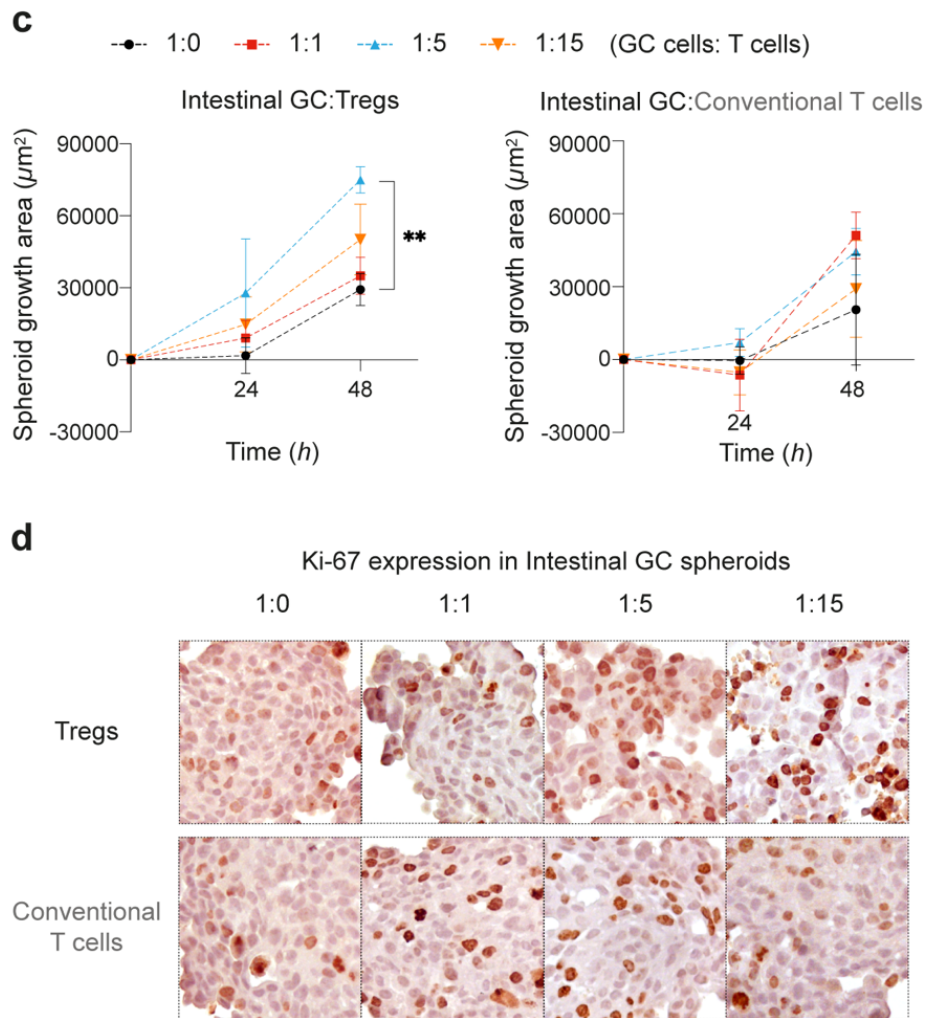
Figure 5. Spheroid growth after co-culture with T cells. ( a , b ) Western blot analysis for phosphorylated (p-ERK1/2) and total ERK1/2 protein levels in intestinal-type IL2R α positive and negative cells after 48 h co-culture with Tregs (1:5 proportion). ( a ) WB scans and ( b ) normalized expression represent three independent experiments. ( c ) Plots of growth area for intestinal GC spheroids co-cultured with Tregs (left graph) or conventional T cells (right graph) for 48 h. Control spheroids (dark) represent intestinal-type GC spheroids without T cells in co-culture. Co-cultures at 1:1, 1:5, and 1:15 proportions are represented in red, blue, and orange, respectively. Data shown mean ± SD of three independent co-cultures. * p < 0.05, ** p < 0.01, *** p < 0.001. Two-way ANOVA with Dunnett’s multiple comparisons test. ( d ) Representative images of Ki-67 nuclear expression (dark brown nuclei) in intestinal-type GC spheroids after 48 h of co-culture with Tregs or conventional T cells, at different 1:0 (control), 1:1, 1:5, or 1:15